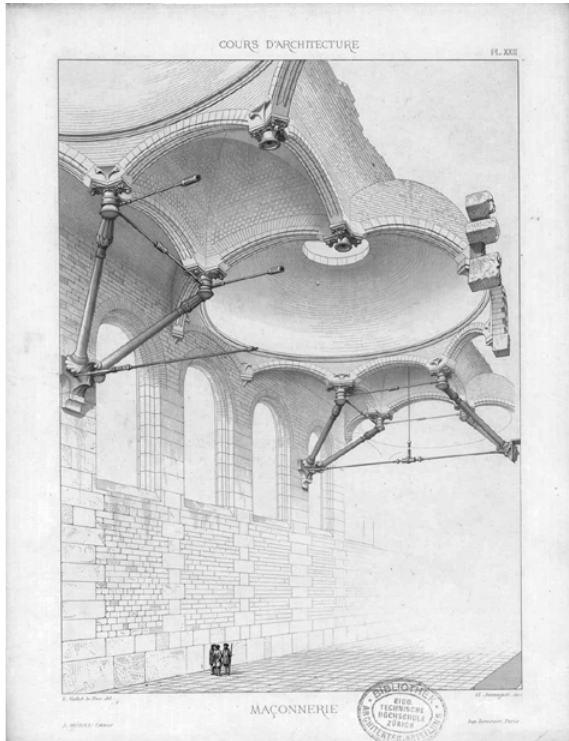
fig. 5. Masonry design. (Viollet-le-Duc 1864, plate XXII). Note : By fading the non-essential aspects (selective quality of representation), this representation was planned for us to focus on the metal structure supporting the domes (directive quality of